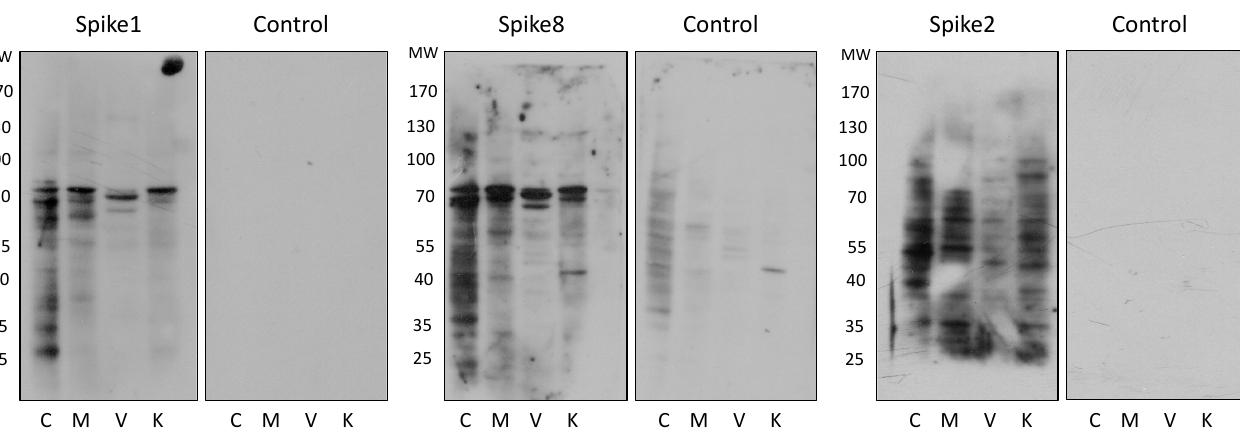
We observed a specific interaction of spikes 1 and 8 with PDIA4, whereas neither spike 2 nor the core protein of HAstV-1, which were used as negative controls, recognized the PDIA4 protein (Figure 3B). These findings strongly suggest that PDIA4 might be one of the binding partners for spikes 1 and 8 originally identified in the far-Western assay and also indicates that the interaction of the capsid spike of HAstV with PDIA4 is serotype-specific.